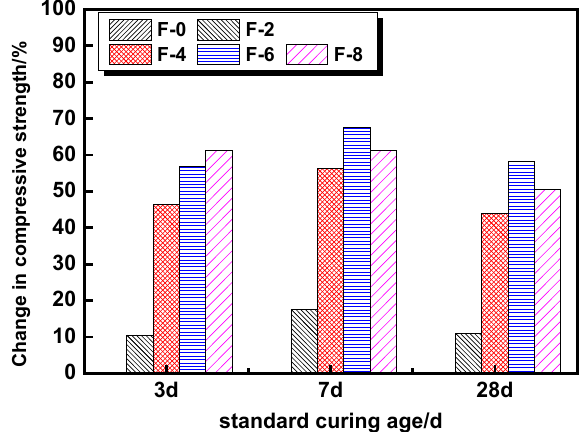
Figure 4. Normalized compressive strength of all stabilized soil related to F-0. Table 6. Standard and immersion compressive strength values of all specimens.